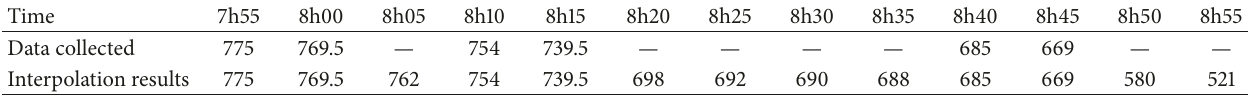
Table 1: Collected and synthesized data for 𝑃2 of Balexert parking with average number of available parking spaces.